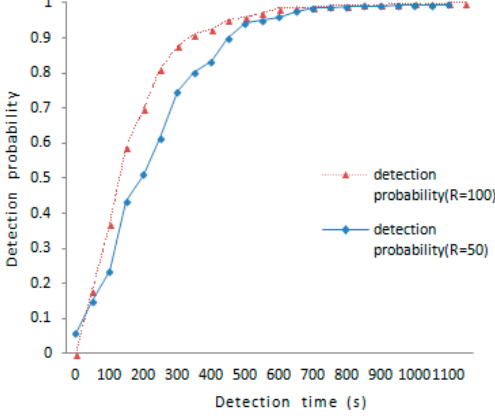
Figure 3. Detection probability versus detection time.